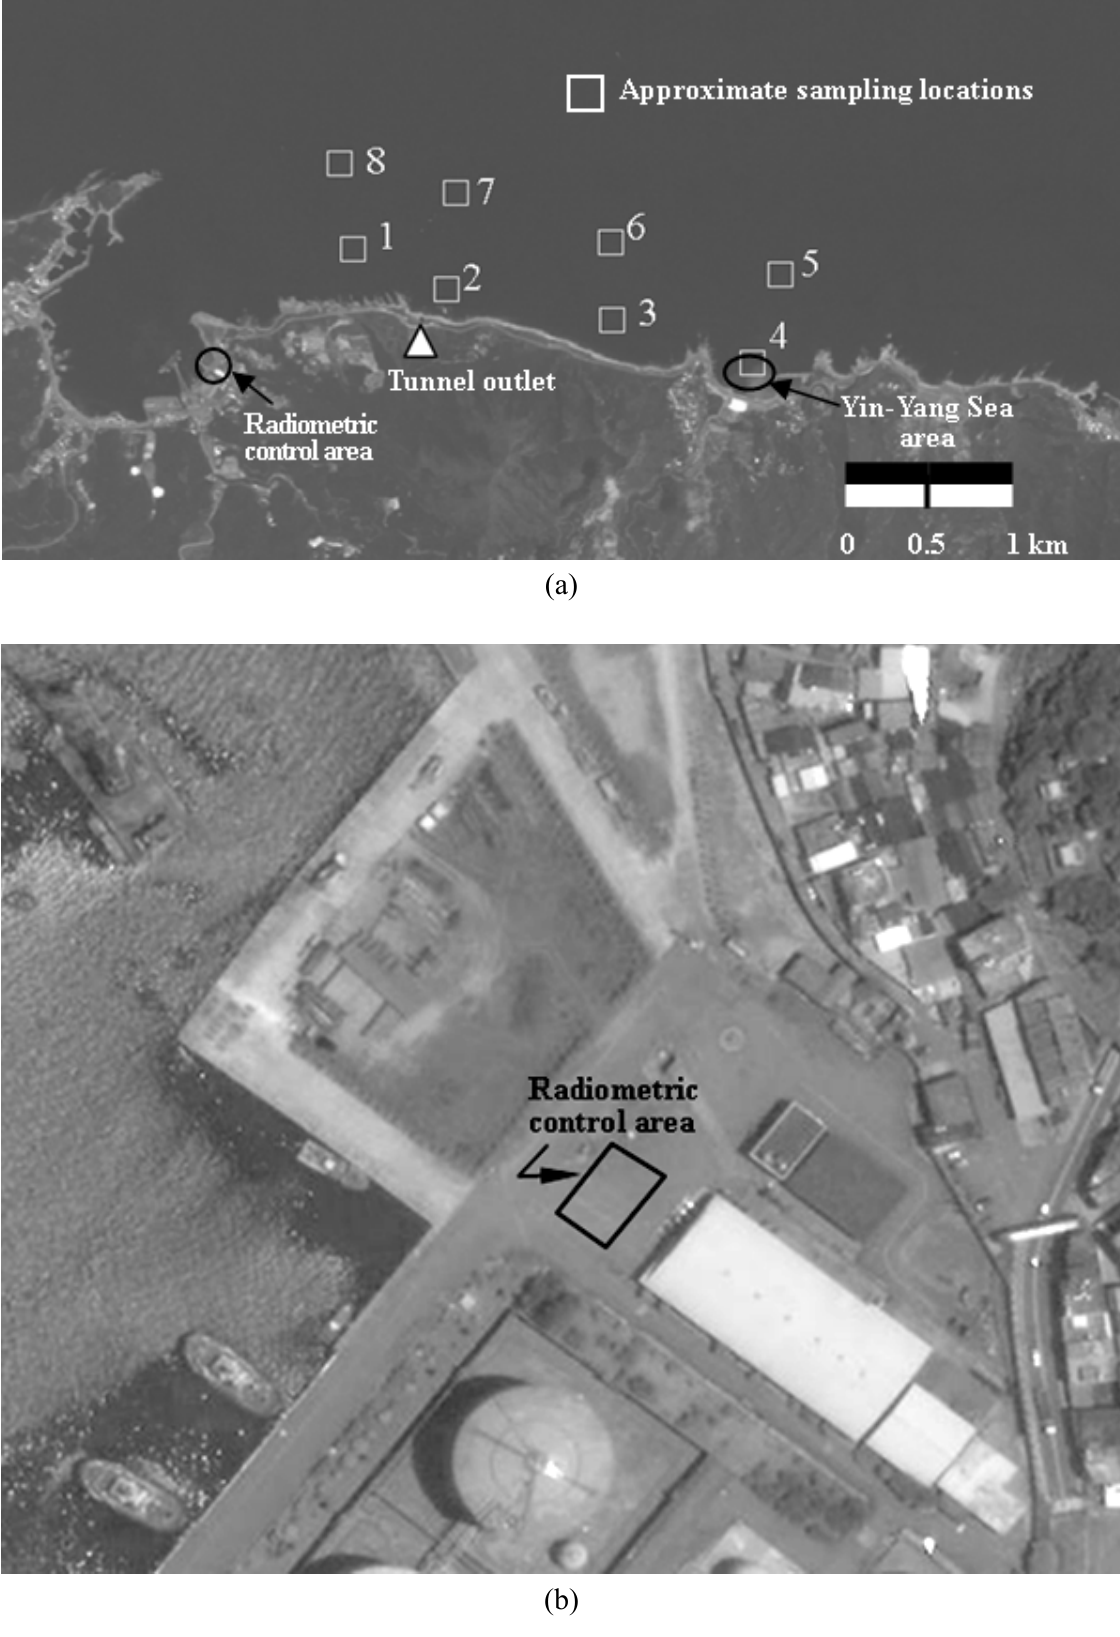
Figure 2. Water sampling locations in the coastal area near the YST tunnel outlet (a) and the radiometric control area